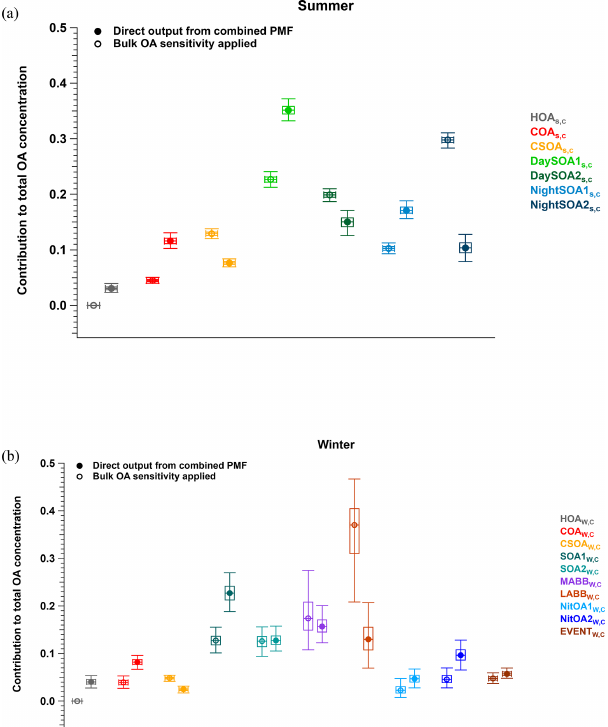
Figure 11. Box-and-whisker diagrams of factor contributions to to- tal OA with and without applying the factor dependent sensitivities for (a) summer and (b) winter within accepted solutions. For each pair of factors, the contribution without factor-dependent sensitivity applied is shown in the left box (open symbols), whereas the con- tribution corrected by factor-dependent sensitivity is shown in the right box (filled symbols). The box-and-whisker diagram shows the mean (open and filled circle), median (horizontal bar), interquartile range (rectangle, the 25th percentile is the lower edge, and the 75th is the upper edge), and minimum and maximum values (whiskers). Note that, here, the contribution of the InorgNit factor and the con- tributions of NO + and NO + from inorganic nitrate in each factor 2 Figure 10. Comparison between the sum of factor concentrations are in each time point with (in red) and without (in blue) taking the factor-dependent sensitivity into account and total OA measured by AMS for summer in panel (a) and winter in panel (b) . A linear fit is conducted based on the Levenberg–Marquardt least-orthogonal- distance method. Note that, here, the contribution of the InorgNit factor and the contributions of NO + and NO + from inorganic ni- 2 trate in each factor are excluded.